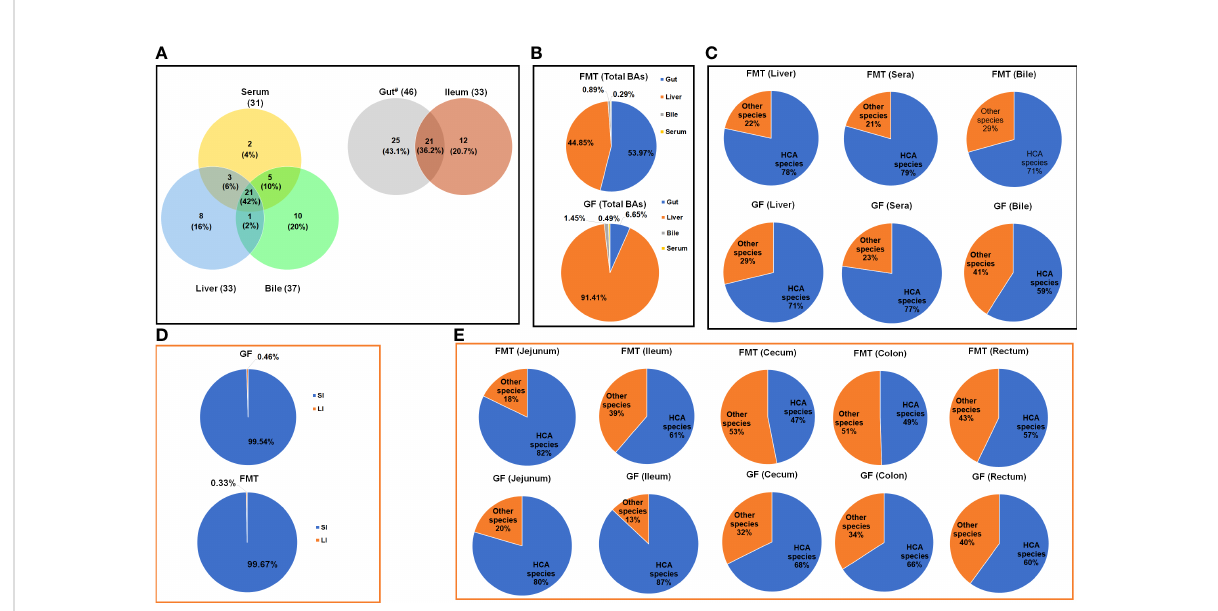
FIGURE 1 Concentrations of the total bile acids (BAs) in FMT and GF piglets. Changes in composition (A) and percentage (B) of total BAs in the liver, bile, serum, and gut of GF piglets after colonization. Microbiota-induced changes in the composition of HCA species in the liver, bile, and serum (C) . (D) Effects of colonization of pig microbiota on BA concentration in the small intestine (SI) and large intestine (LI); (E) Microbiota-induced changes in the percentage of HCA species concentrations in the total BAs in the jejunum, ileum, cecum, colon, and rectum. Gut # represents the jejunum, cecum, colon, and rectum, except